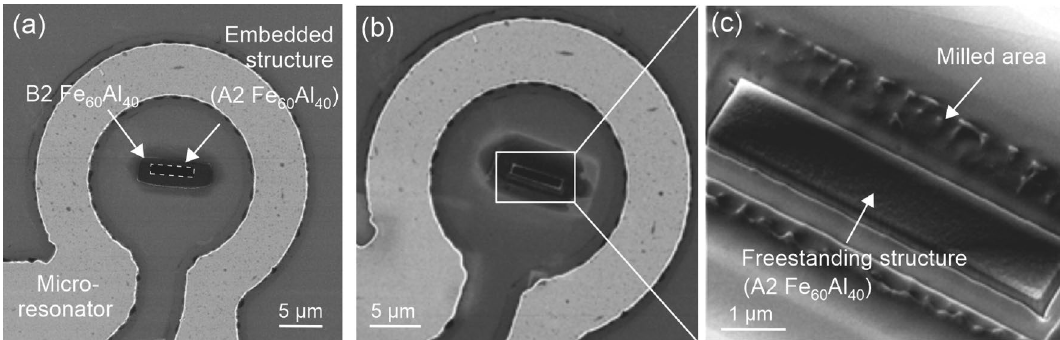
Figure 1. ( a ) HIM image of the A2 Fe 60 Al 40 strip embedded in a B2 Fe 60 Al 40 template ( b ) Milling of the region around the A2 Fe 60 Al 40 strip to produce a freestanding structure, detailed in ( c